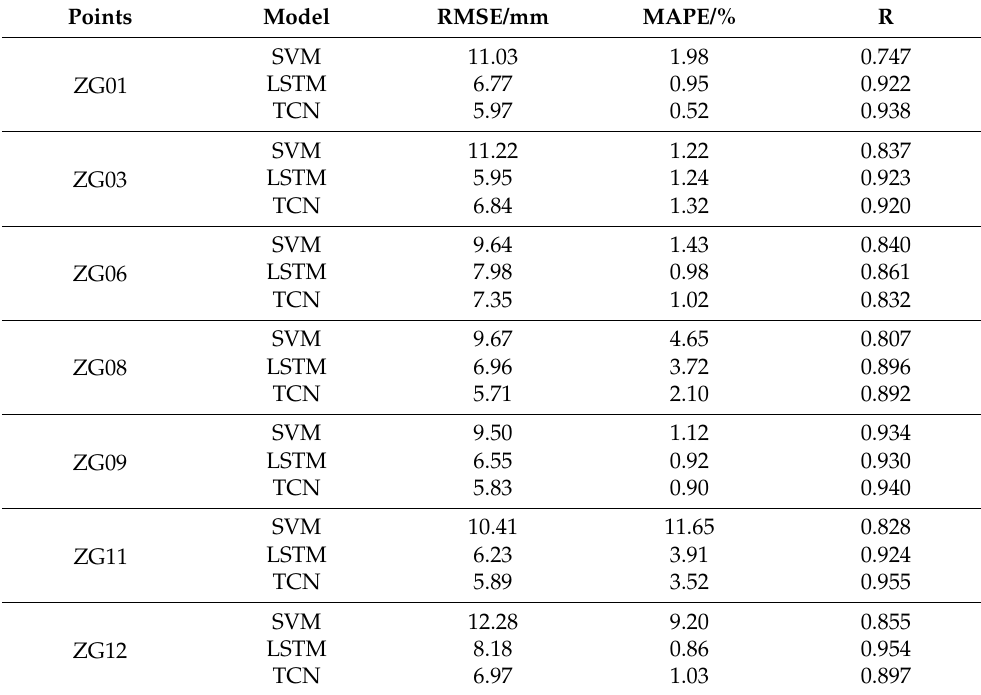
Table 6. The periodic displacement prediction accuracy among the SVM, LSTM, and TCN models for the selected seven points. Points Model RMSE/mm MAPE/% R ZG01